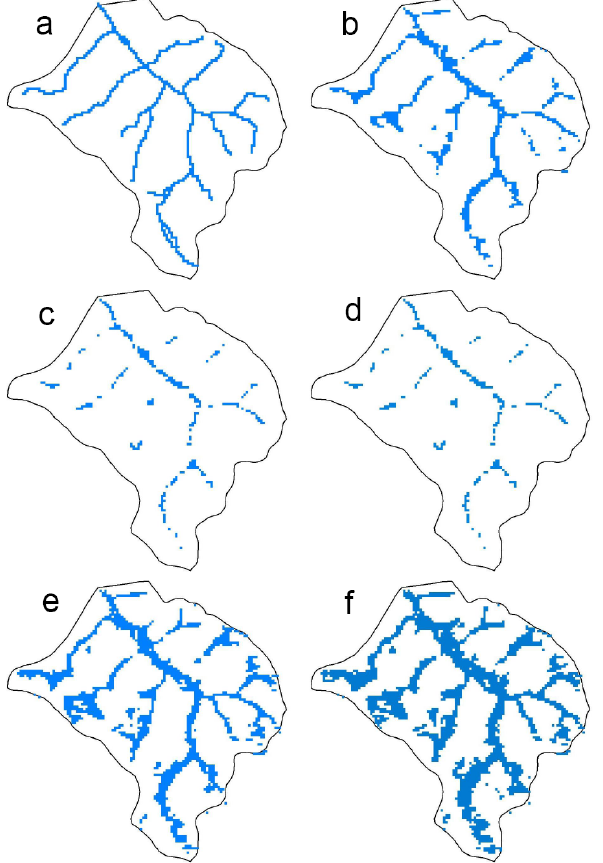
Figure 3. Zastlerbach reference network (a) and effects of different parameter sets on the 3 Fig. 3. Zastlerbach reference network (a) and effects of different spatial distribution of stream cells (b-f). 4 parameter sets on the spatial distribution of stream cells (b–f) .